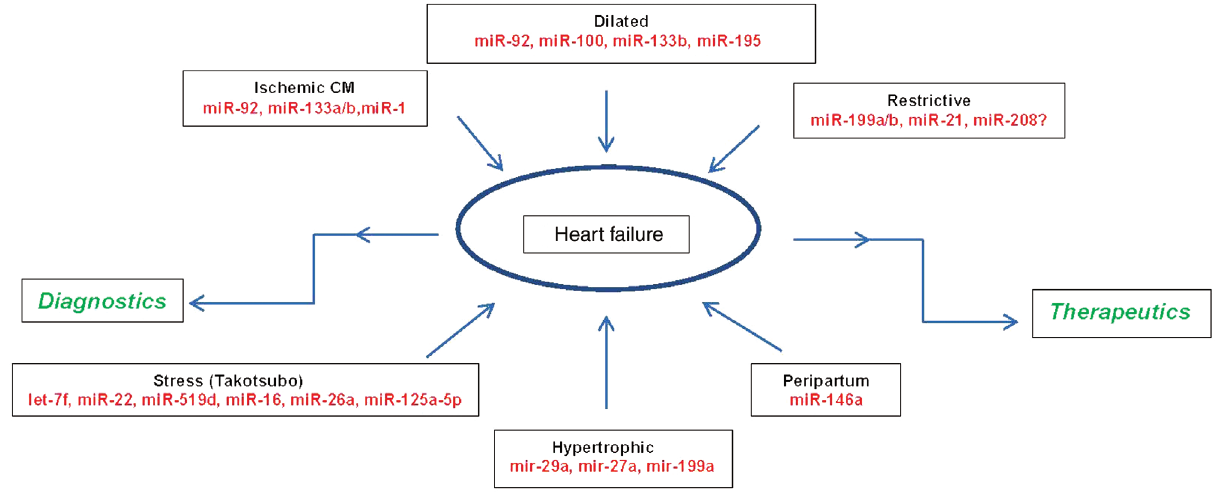
Figure 1 MicroRNAs in cardiomyopathies with different